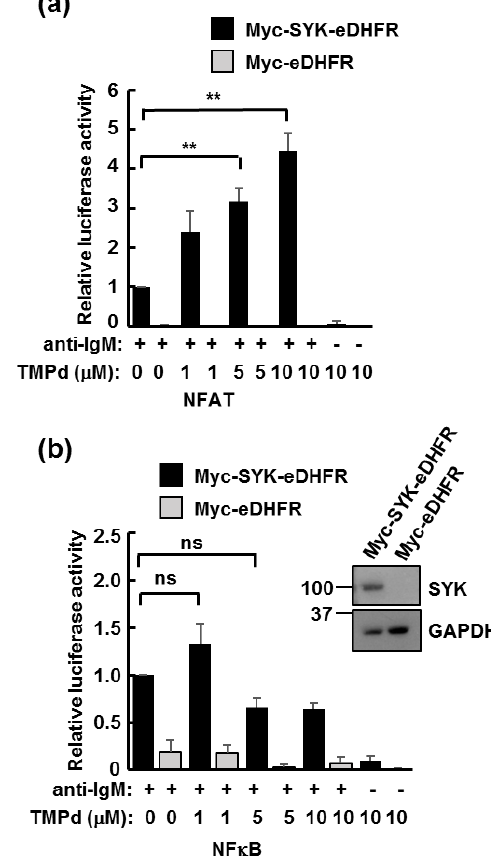
Figure 4. The trimethoprim (TMP) dimer enhances B cell antigen receptor (BCR)-dependent